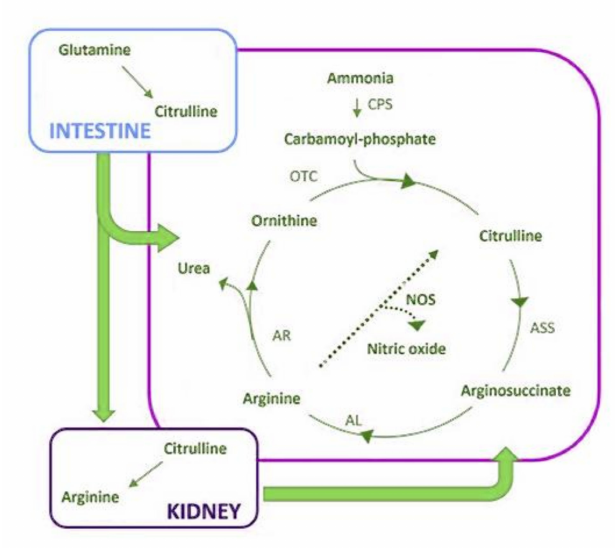
Figure 3. Decrease in citrulline level has been observed for many soft tissue sarcomas. Citrulline belongs to the arginine metabolic pathway: it is produced by enterocytes from glutamine and is released into the blood, where is taken up by the kidney for the synthesis of arginine or is transported to the liver where it participates in the transformation of ammonia to urea. Abbreviations: CPS, carbamoyl phosphate synthetase; ASS, argininosuccinate synthase; AL, argininosuccinate lyase; AR, arginase; OTC, ornithine